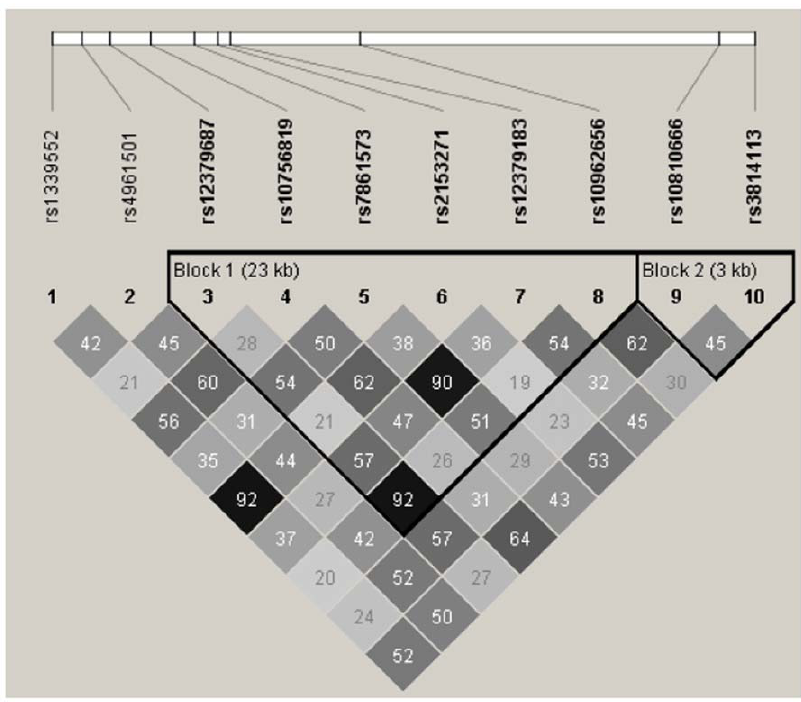
Figure 1. LD-plot of 10 SNPs on 9p22 from individuals included in the analysis. The LD-plot was generated with Haploview based on r 2 of the 10 SNPs on 9p22 in 992 Caucasian women with genotyping information and transvaginal ultrasound results available.